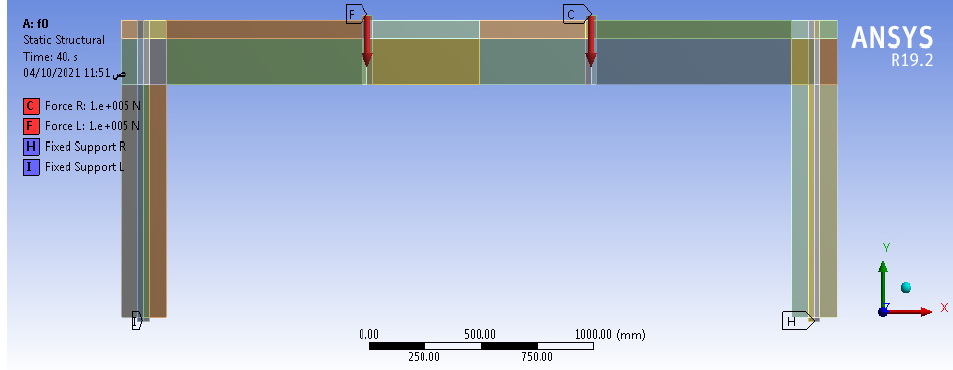
Figure 4. Loading of all samples.